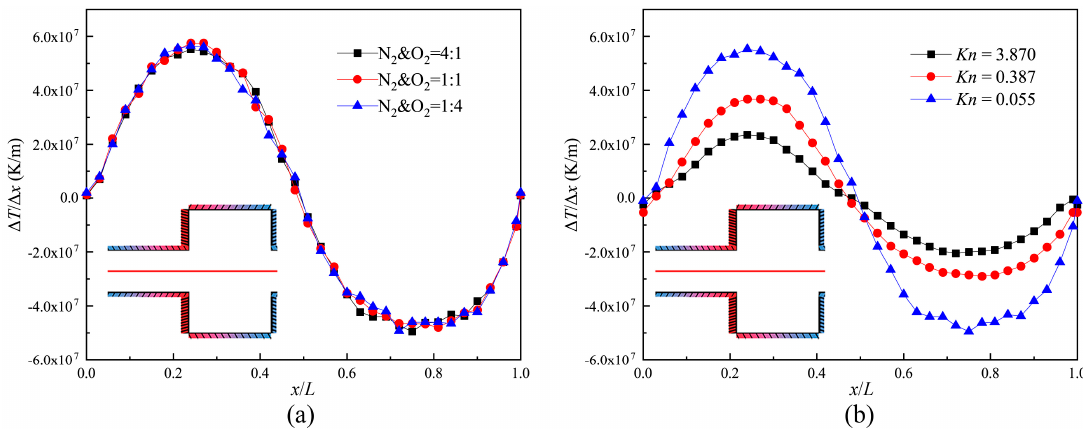
Figure 6. Temperature gradient on the central axis of the channel. ( a ) Kn = 0.055; ( b ) N 2 and O 2 = 4:1.